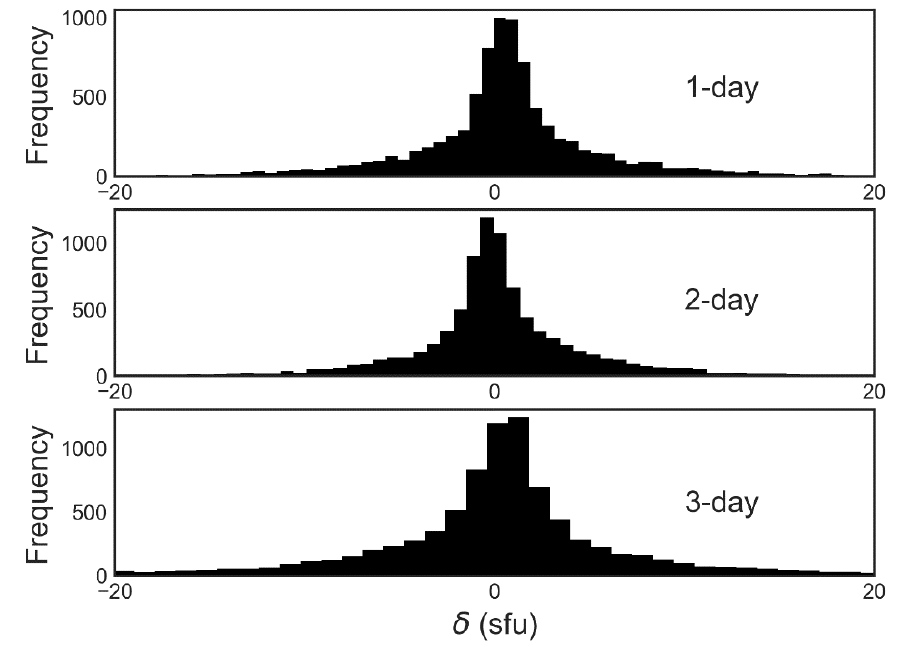
Figure 8. The frequency distribution histogram of the difference between the observed value and the predicted value. The top, middle, and bottom panel represent the results for the 3-day, 2-day, and 1-day forecast. The abscissa represents δ = F obs − F pre ( suf ) .